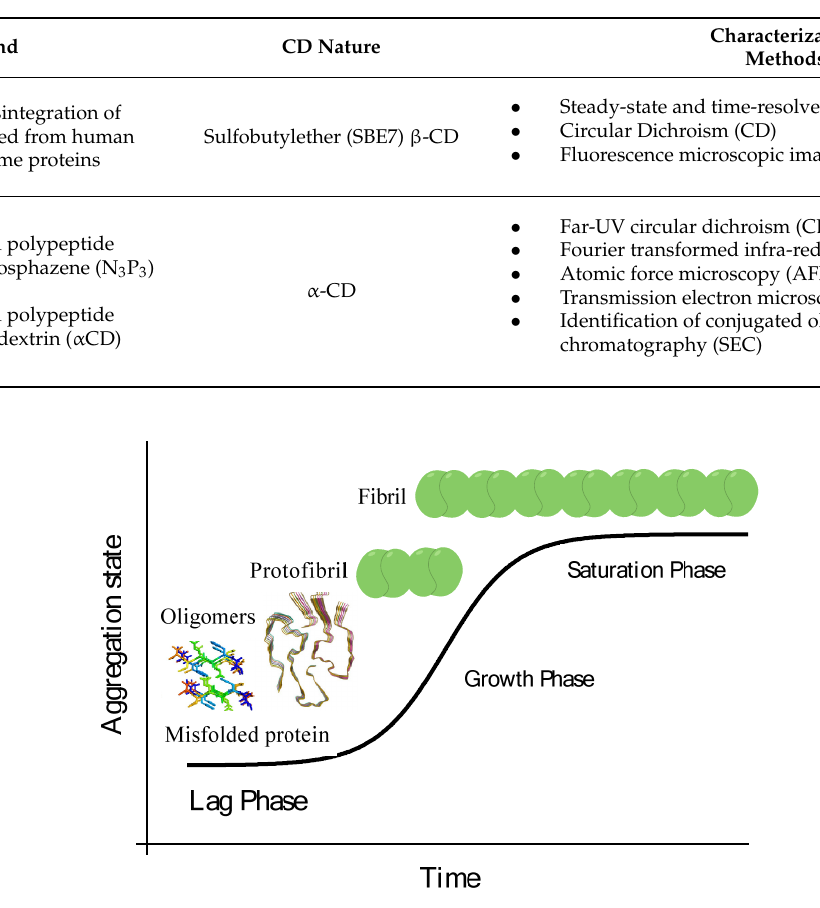
Figure 5. The kinetic proceeding of protein amyloid fibrillation comprising (Lag phase) aggregation of misfolded monomers into tiny intermediate oligomers; (Growth phase) re-arrangement of these oligomers into organized fibrils containing the cross-beta structure; (Saturation phase) association of beta structured oligomers into proto-fibrils [120].